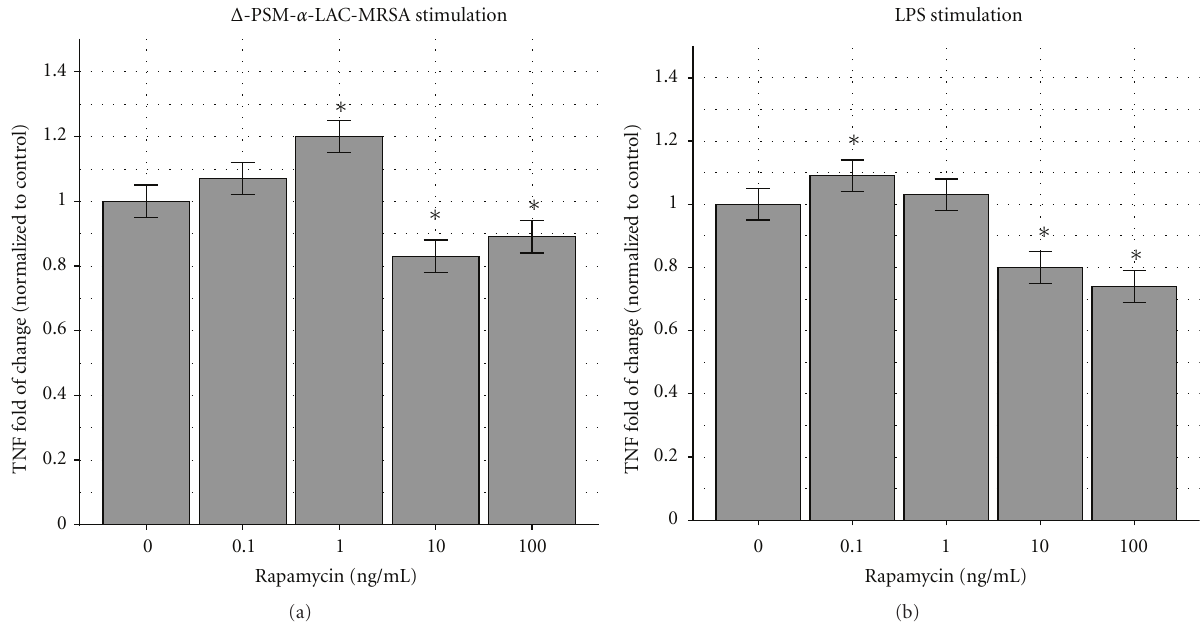
Figure 3: (a) E ff ects of rapamycin on MRSA RAW264.7 murine macrophages stimulated by Δ -PSM- α LAC. Δ -PSM- α LAC (USA300 PSM- α -depleted strain) stimulated more TNF secretion by RAW264.7 murine macrophages when exposed to rapamycin at 0.1 and 1ng/mL and less when exposed to rapamycin at 10 and 100 ng/mL. The response at 0.1ng/mL (first column) had an increase of 7%, not significantly di ff erent ( P < 0 . 05) than the untreated control (first column). The response at 1 ng/mL (third column) had an increase of 20%, and the responses at 10ng/mL (fourth column) and 100 ng/mL (fifth column) demonstrated decreases of 17% and 11%, all significantly di ff erent from the control ( P < 0 . 05). The results are depicted as fold of change compared to the control with 95% confidence intervals shown as “error bars.” ∗ P < 0 . 05. The control response was 28,554 ± 571 pg/mL. (b) E ff ects of rapamycin on RAW264.7 murine macrophages stimulated by LPS. Lipopolysaccharide (LPS) stimulated more TNF secretion by RAW264.7 murine macrophages when exposed to rapamycin at 0.1 and 1ng/mL and less when exposed to concentrations of 10 and 100 ng/mL. The response at 0.1 ng/mL had an increase of 9%, significantly di ff erent ( P < 0 . 05) from the untreated control (first column). The response at 1ng/mL had an increase of 7% (not significantly di ff erent), and the responses at 10ng/mL (fourth column) and 100 ng/mL (fifth column) demonstrated decreases of 20% and 26%, both significantly di ff erent from the control ( P < 0 . 05). The results are depicted as fold of change compared to the control with 95% confidence intervals shown as “error bars.” ∗ P < 0 . 05. The control response was 32,486 pg/mL ± 650